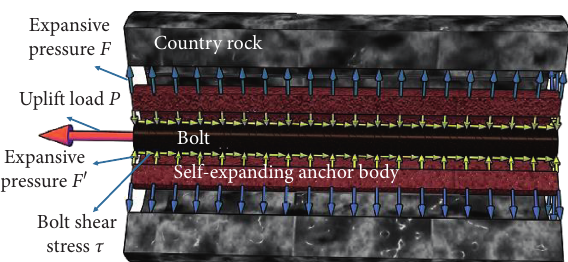
Figure 20: Forced state diagram of self-expanding